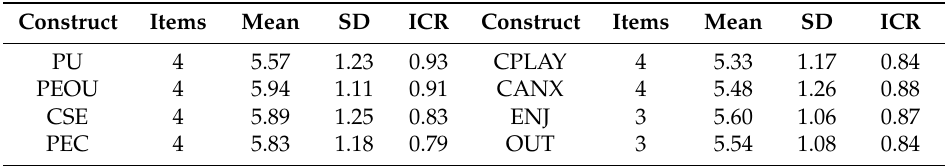
Table 1. Mean, Standard Deviation and Internal Consistency Reliability of the measurement Constructs and Items.